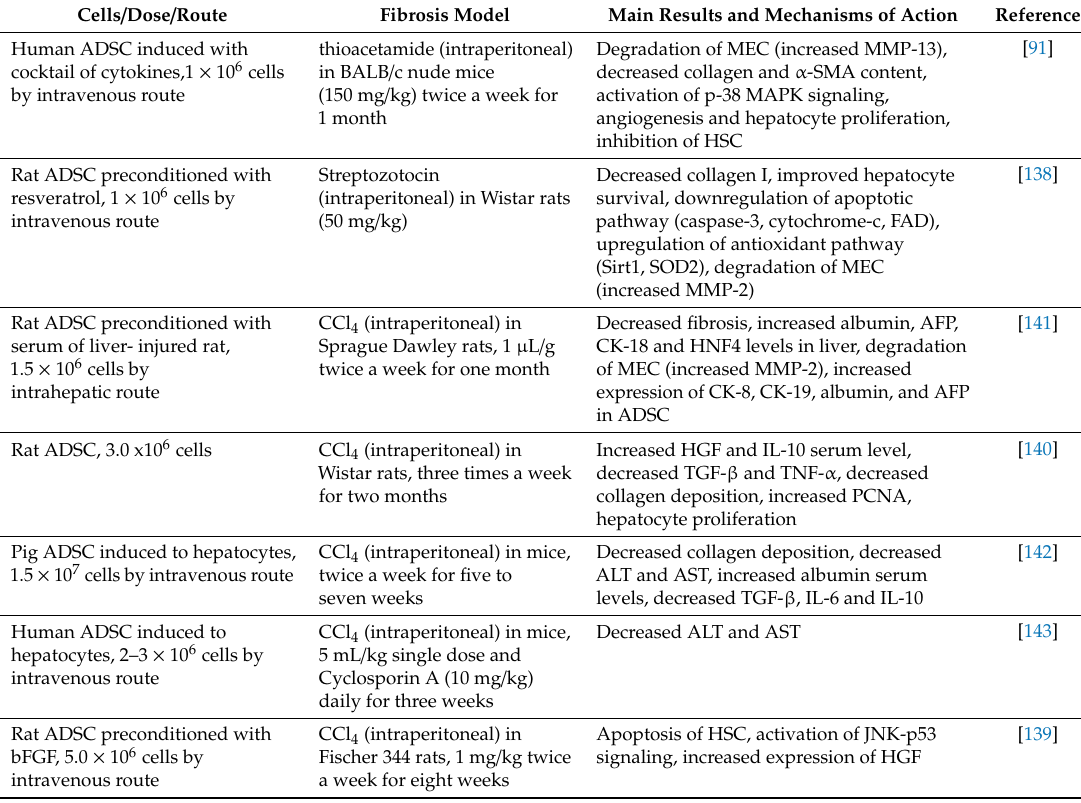
Table 5. Experimental liver fibrosis and adipose-derived mesenchymal stem